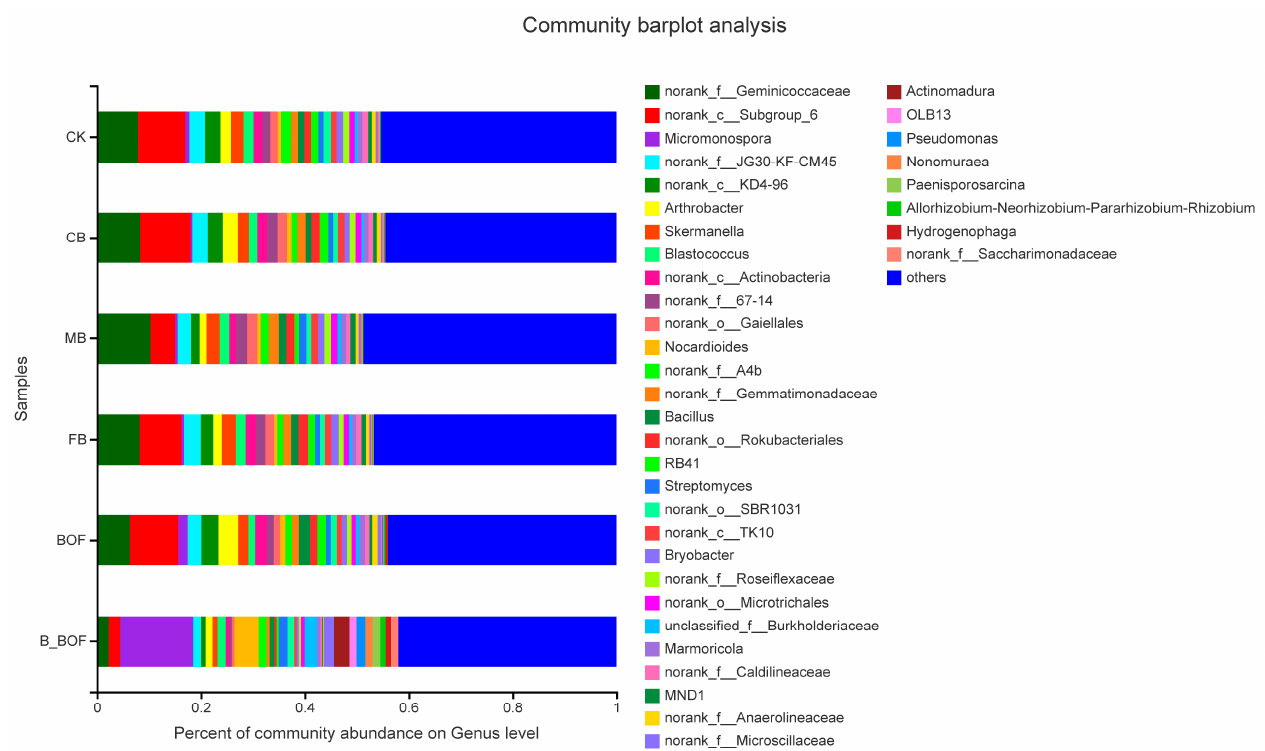
Figure 4. Relative abundance of the predominant genera (top 40) in each sample. Taxa with an abundance < 0.01 are included in “others”. The x -axis represents the relative abundance of all communities, and the y -axis represents different communities.